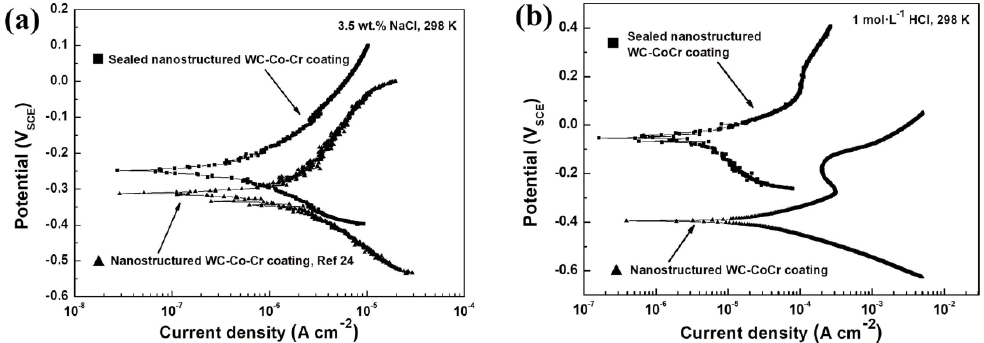
Figure 4. Potentiodynamic polarization curves of unsealed and sealed nanostructured WC-CoCr